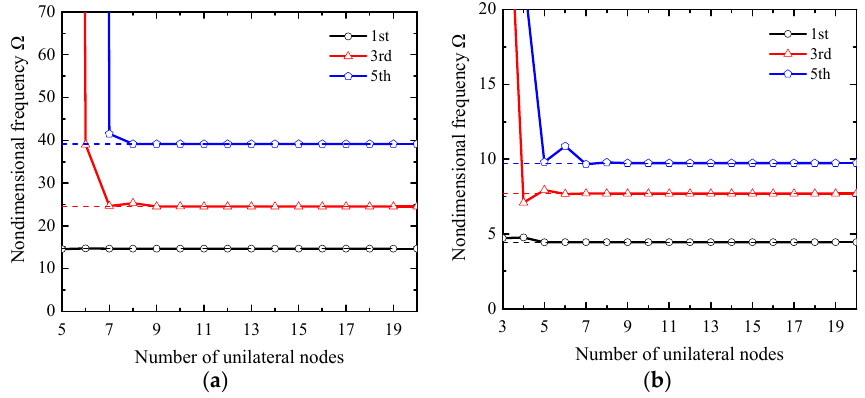
Figure 6. Variations of nondimensional frequencies Ω for SSSS laminates (0°, 90°, 0°) versus the number of nodes: ( a ) h/b = 0.001, k t = k r 2 = 10 8 , k r 1 = 0; ( b ) h/b = 0.2, k t = k r 2 = 10 8 , k r 1 = 0.